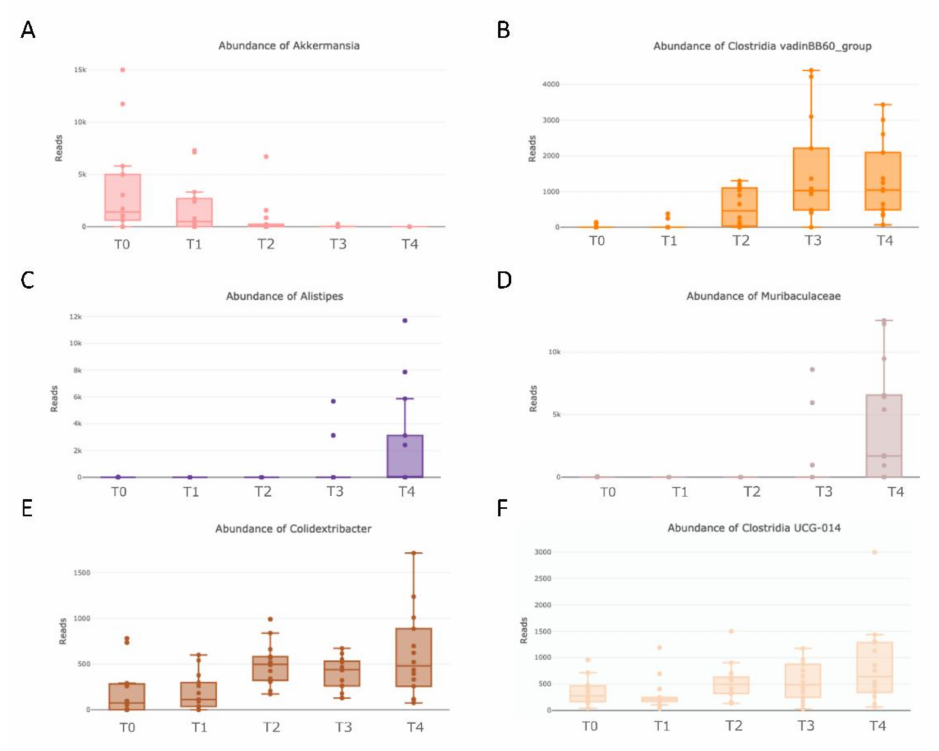
Figure 5. Box plots representing the relative abundance of genera ( A ) Akkermansia , ( B ) Clostridia_vadinBB60_group , ( C ) Alistipes , ( D ) Muribaculaceae, ( E ) Colidextribacter , and ( F ) Clostridia UCG-014 . (Number of mice: T1 n = 14, T2 n = 12, T3 n =14, and T4 n